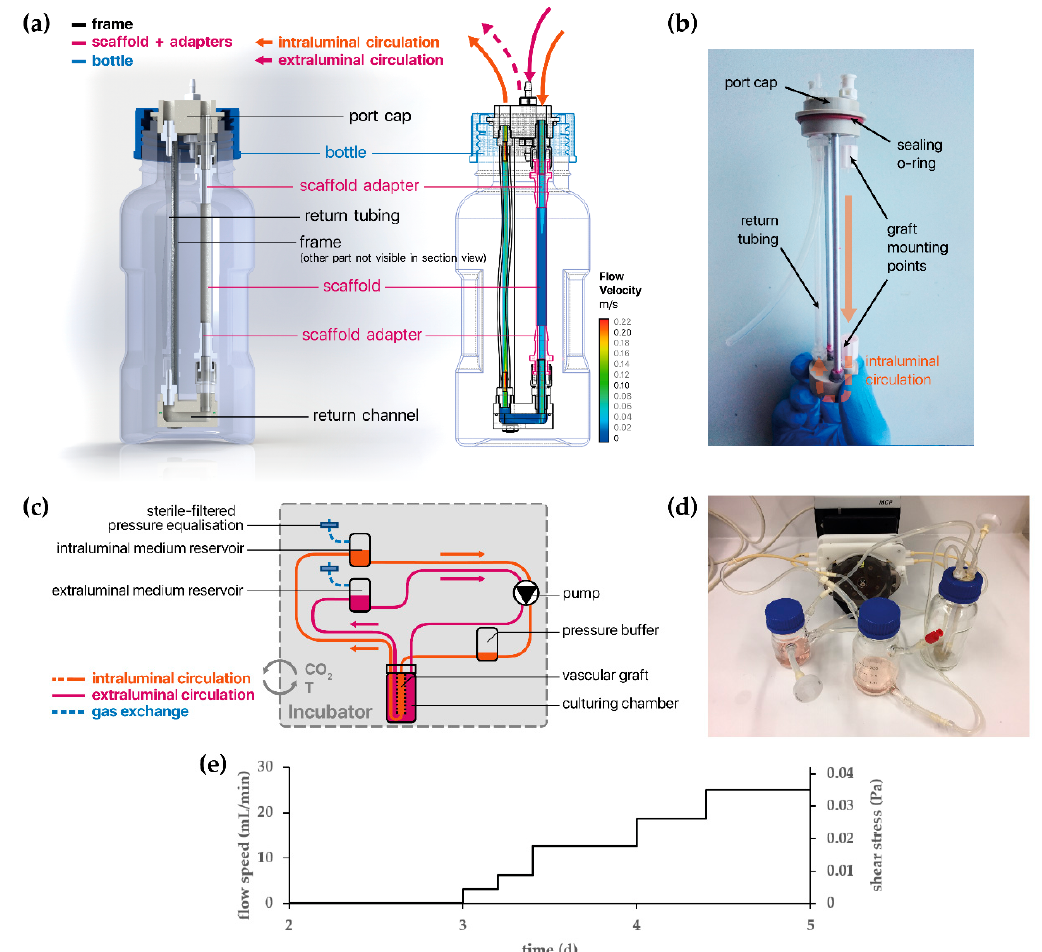
Figure 2. ( a ) A cross-sectional schematic representation of the culturing chamber and its parts. The wireframe model on the right is overlaid by the results of an in silico simulation and shows the flow velocity when the system is perfused with a flow rate of Q = 20 mL/min. ( b ) This photograph shows the graft frame (without scaffold), once it is taken out of the culturing chamber. ( c ) A schematic representation of the entire bioreactor setup, showing the circulation and connections to the medium reservoirs and pressure buffer/bubble trap. ( d ) A photograph showing the assembled bioreactor setup with all the components for the intraluminal circulation. ( e ) Applied perfusion flow speed as function of time with the corresponding wall shear